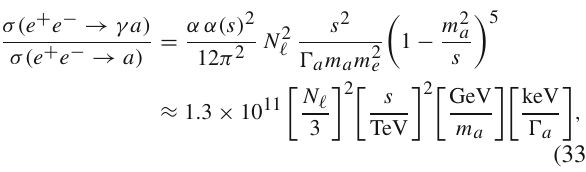
m 2 (cid:10) / m 2 . Because of the anomaly equation, B 1 (τ (cid:10) ) ≈ 1 for Z m a > m (cid:10) and B 1 (τ (cid:10) ) ≈ − m